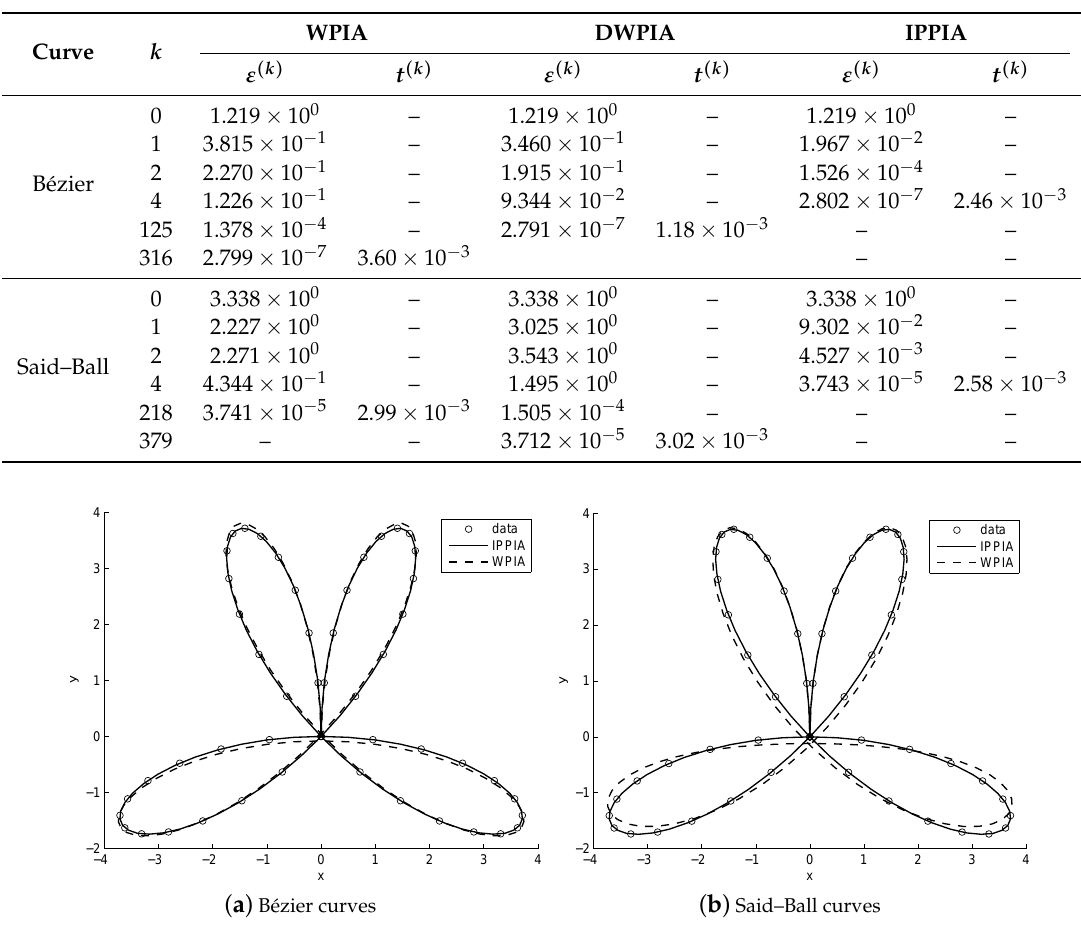
Figure 8. Approximations of 53 points sampled from the helix at the fifth iteration. Table 8. Numerical results when fitting 53 points sampled from the four-leaf clover.